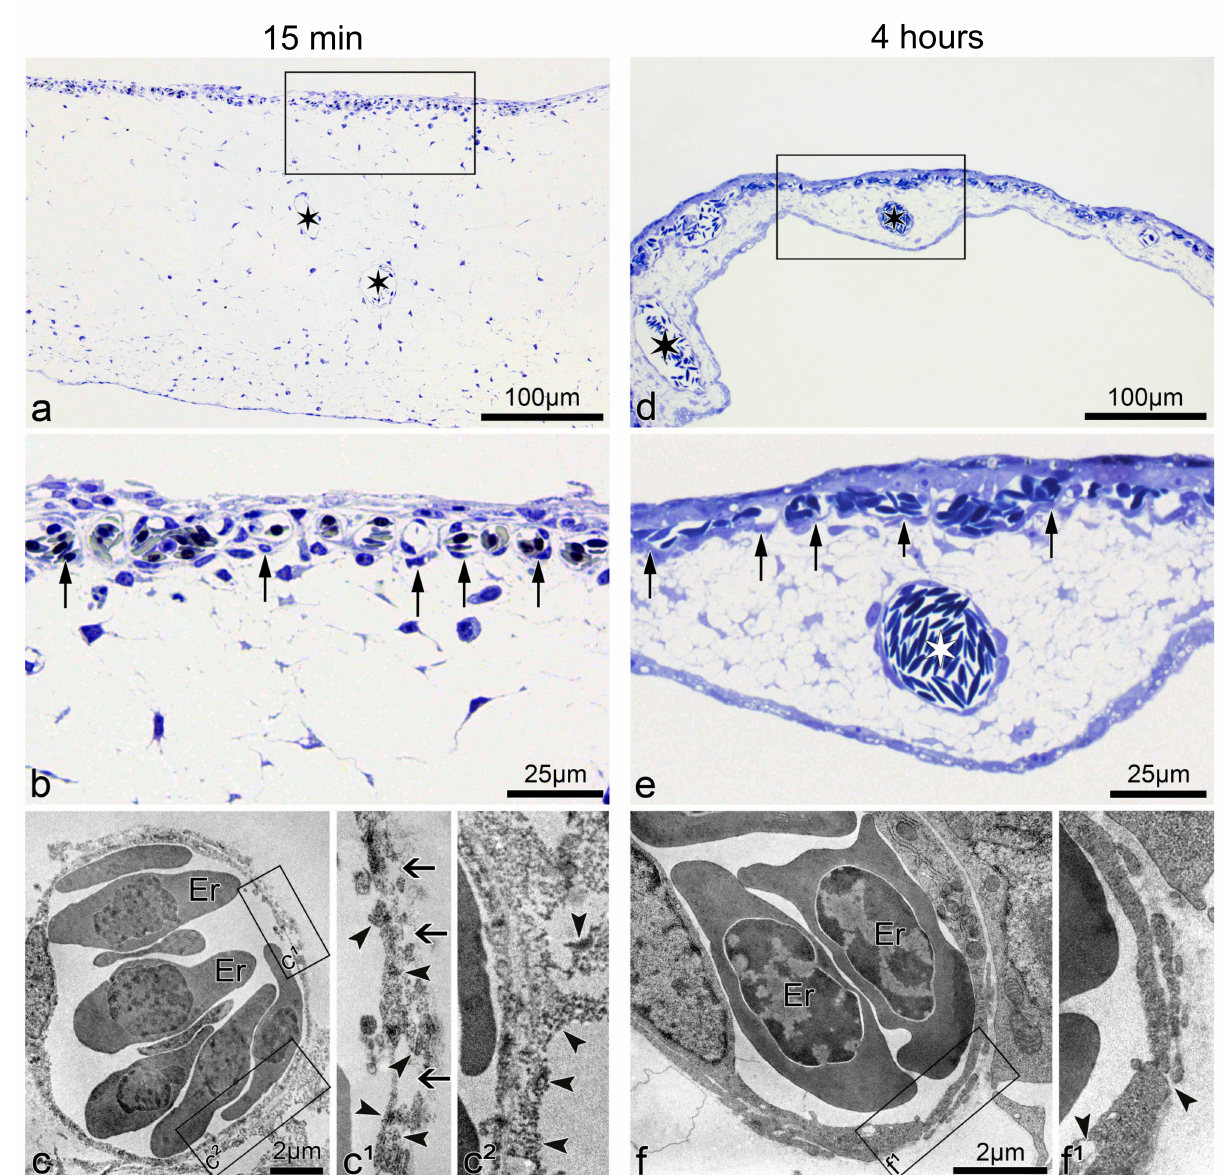
Figure 2. Morphological alteration of CAM vasculature 15 min and 4 h post-75 Gy of MRT. Images ( a , b ): semithin section of CAM fifteen minutes after MRT exposure: Irradiated CAM is enlarged (edematous). The capillary vessels (arrows) appear almost normal at light microscopy. ( c ( c 1 , c 2 )): Ultrastructure of CAM samples shown in ( a , b ) reveal a discontinuous endothelium with gaps and fissures (arrows). Those are most likely responsible for the increased permeability, as demonstrated by the presence of FITC-dextran dots (arrowheads) in the endothelial cell wall ( c 1 ) as well as in the abluminal space ( c 2 ). Images ( d , e ): four hours after 75 Gy of MRT, the CAM thickness decreased, thus almost reverting to the normal morphology. The capillary plexus (arrows) and supplying vessels (white asterisk) appear perfused and intact in semithin sections. Images ( f ( f 1 )): four hours after microbeam exposure, the capillaries regained their normal ultrastructure, as evidenced by the nearly normal endothelial cells. Only occasional vacuoles and fissures were present (arrowheads). Images ( b , c 1 , c 2 , e , f 1 ) are higher magnifications of the rectangles in ( a , c , d , f ), respectively. Er =